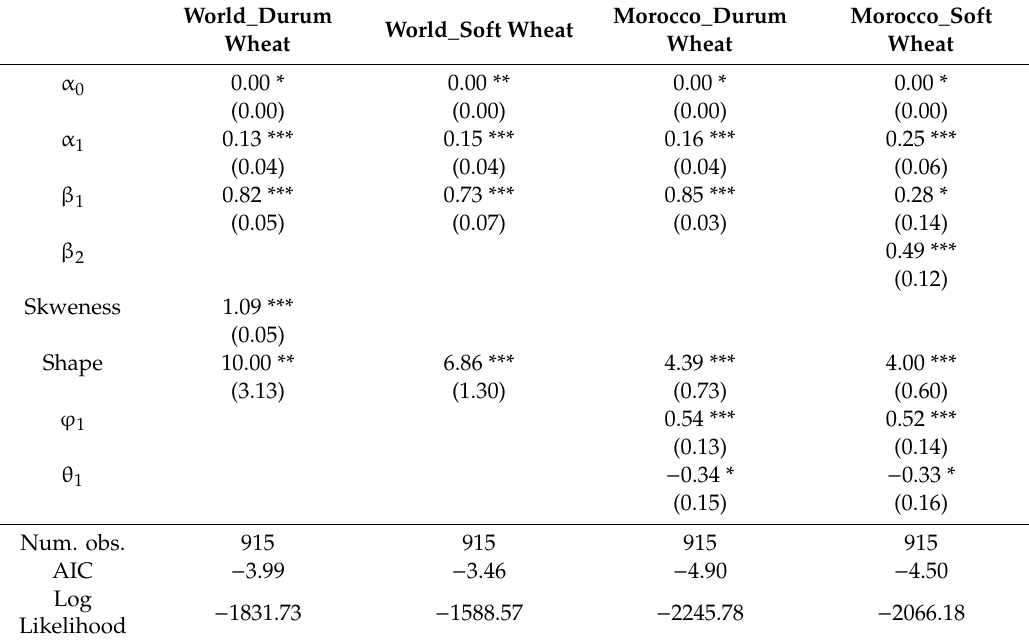
Table 4. ARMA-GARCH parameter